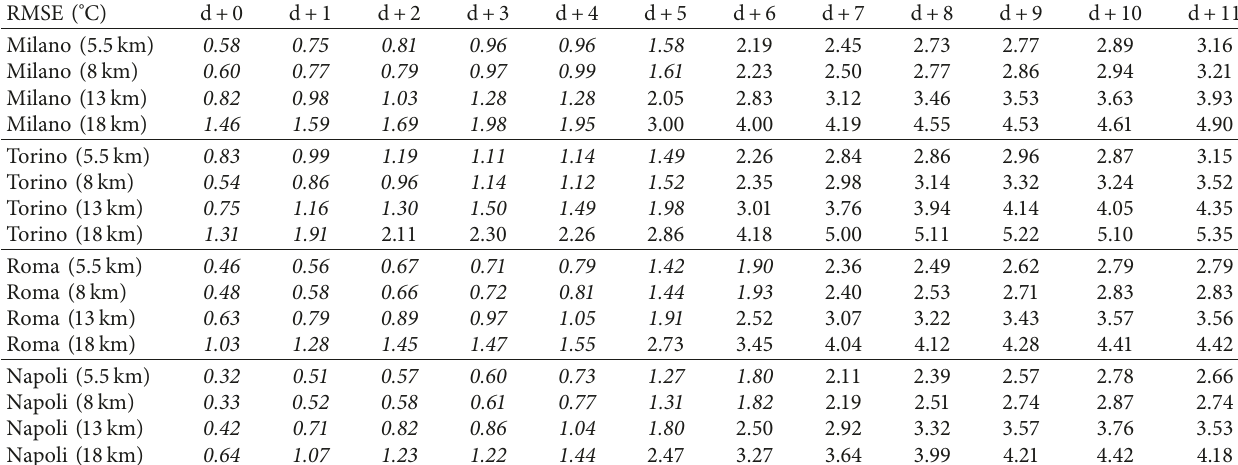
Table 3: RMSE of the e-kmf ™ temperature forecasts at different spatial resolutions and lead times over the Italian cities; values in italics depict a good forecast below the 2 ° C error threshold.